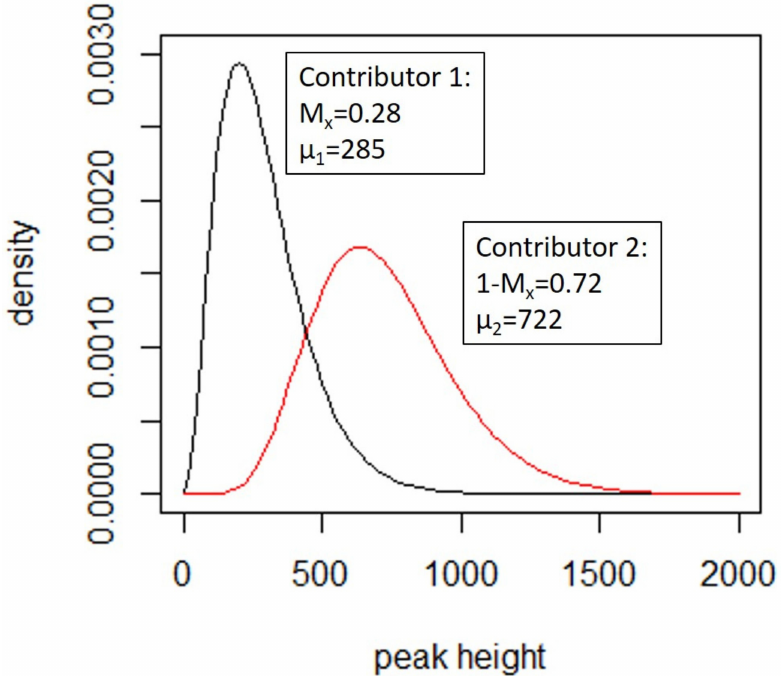
Figure 3. γ distributions for a simple case, where shape parameters = 3.312 and 8.381, respectively and the scale parameter is 86.2. The peak height expectation ( µ ) and Mx are shown for each contributor. The probability density function for the individual peak height contributions are derived from these curves. Reprinted from [62], chapter 7, Copyright (2020) with permission from